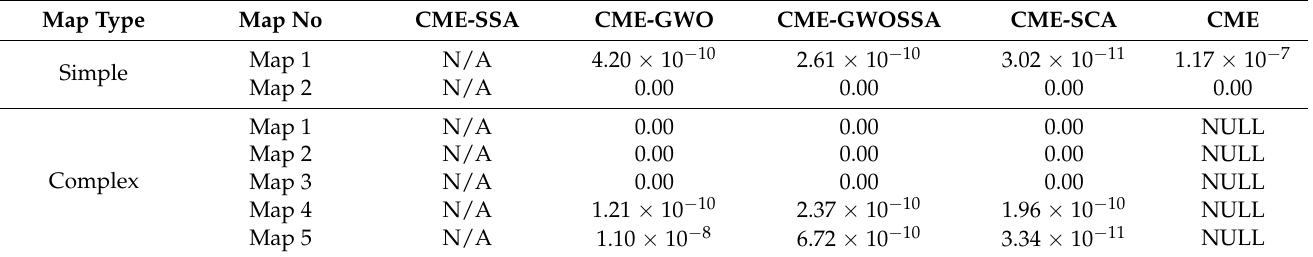
Table 7. p − values for the time consumption results in Tables 2 and 6 as calculated via the Wilcoxon rank − sum test (N/A stands for not applicable, Null, no result).